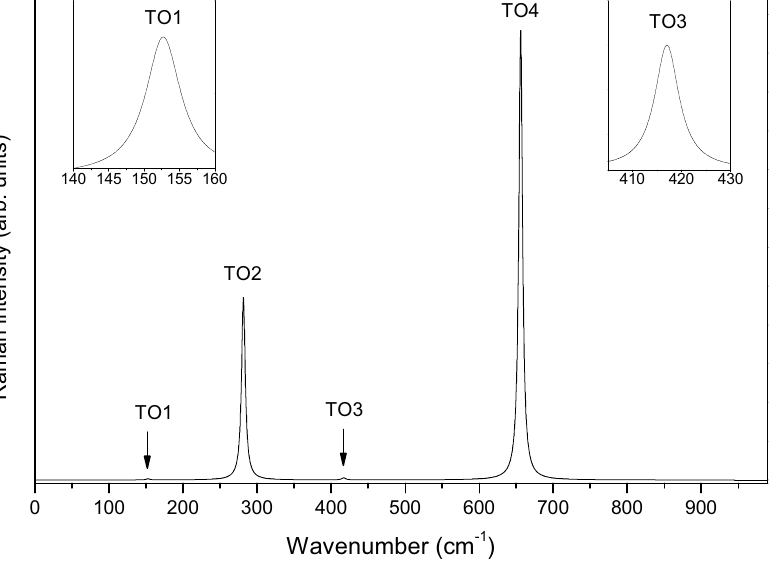
Figure 8. The calculated Raman spectra of LiNbO 3 -type ZnTiO 3 for a x(zz)y scattering configuration in the range of 0~1000 cm − 1 . The spectra displays the TO of A 1